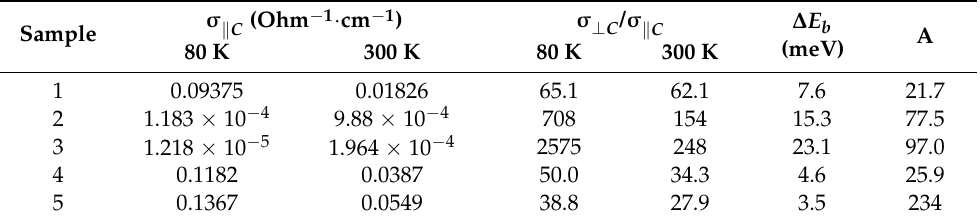
Table 2. Conductivity across the layers and conductivity anisotropy for different samples of n -InSe.